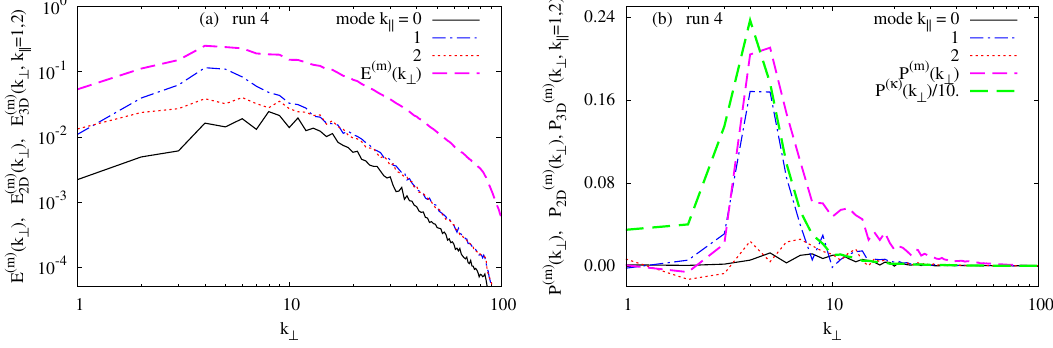
Figure 10. Kinetic energy spectra. ( a , b ) compare the spectra E ( κ ) ( k ⊥ ) , E for runs 1 and 4, respectively. The dashed straight lines, which indicate the k − 2 ⊥ and k − 3 ⊥ scaling, delimit the range k S = 4 ≤ k ⊥ ≤ k Ω = 40.